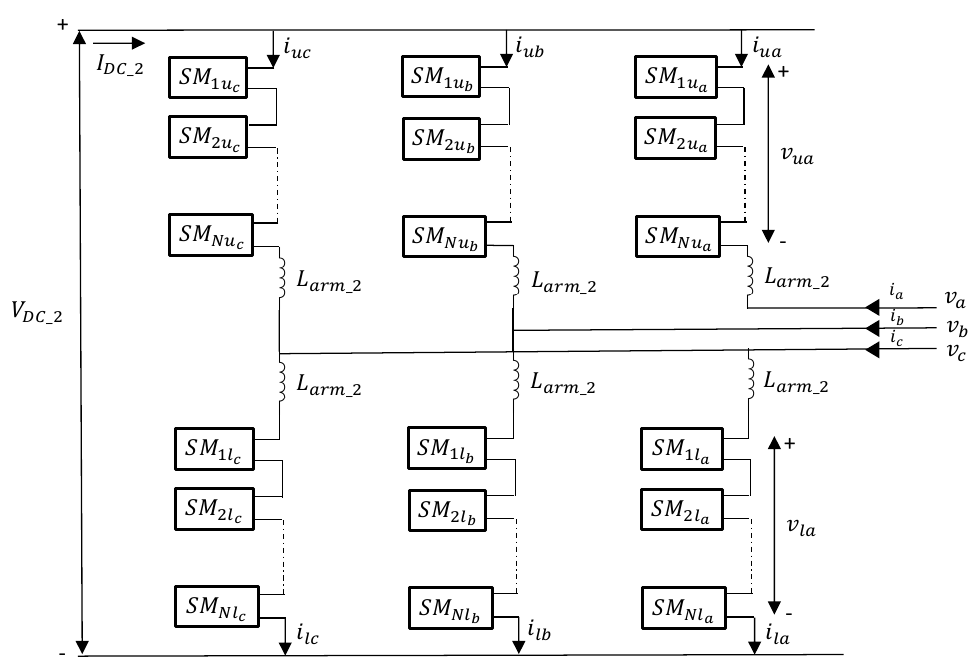
Figure 10. MMC-2